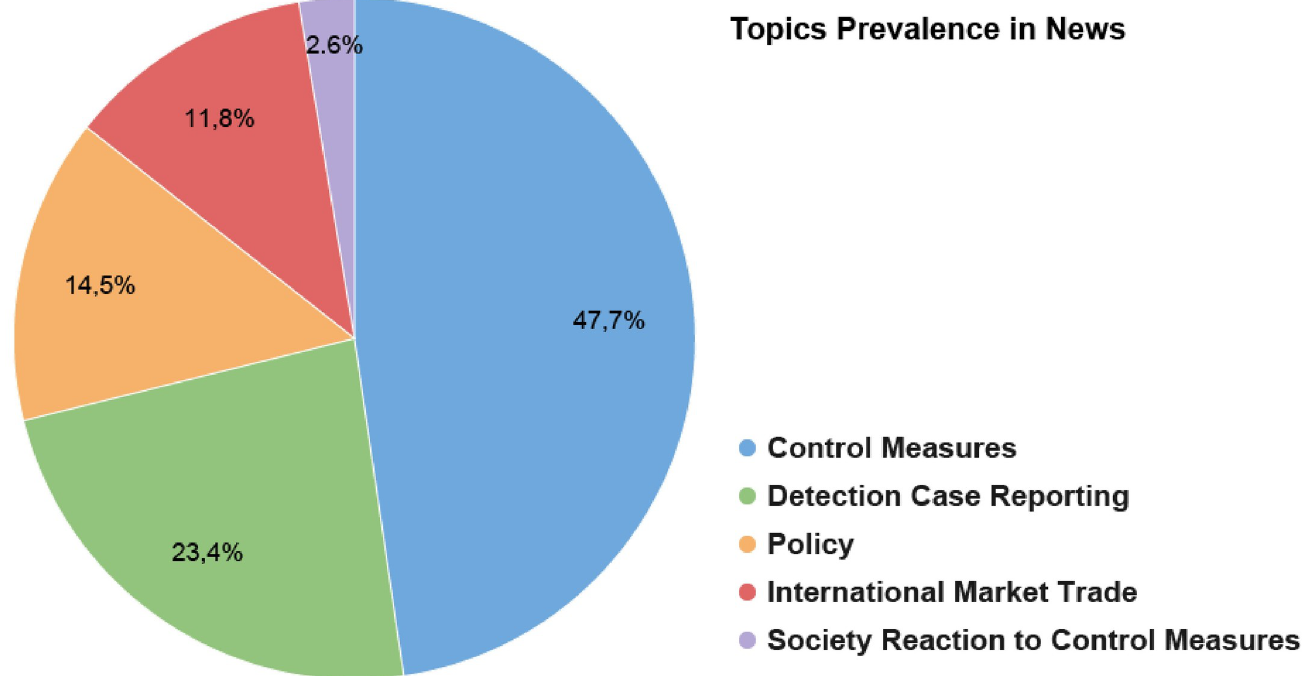
Fig 2. Percentage of documents per topic